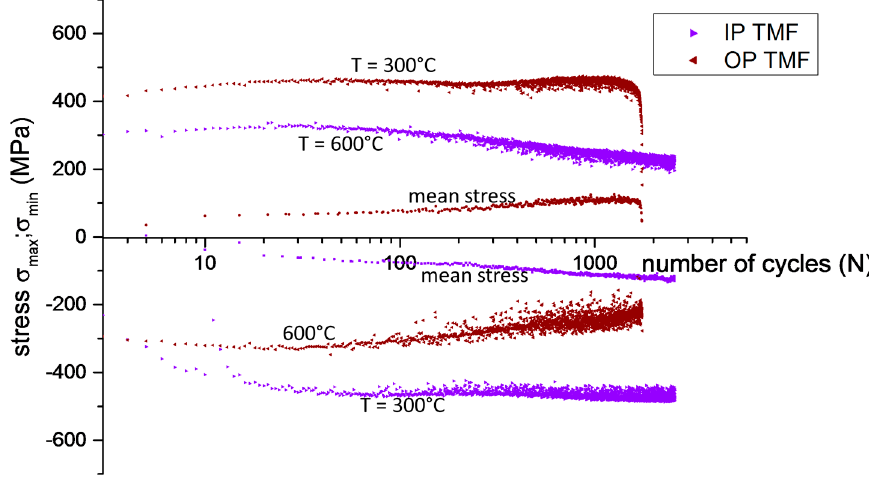
Figure 6. Cyclic stress response curves during thermomechanical fatigue tests (IP TMF and OP TMF) under plastic-strain control at Δε pl /2 = 0.2% (f = 0.059 Hz) in the temperature range of 300 to 600 °C.